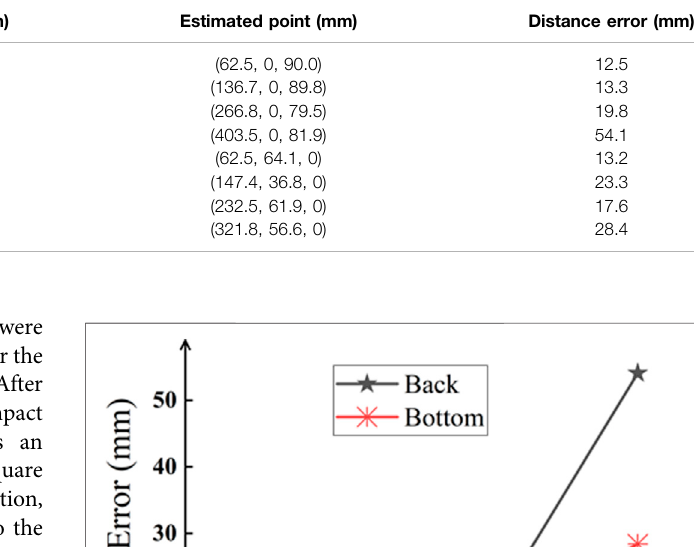
TABLE 3 | Localization results.